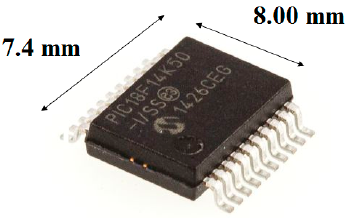
Figure 4. Microcontroller. Figure 4.